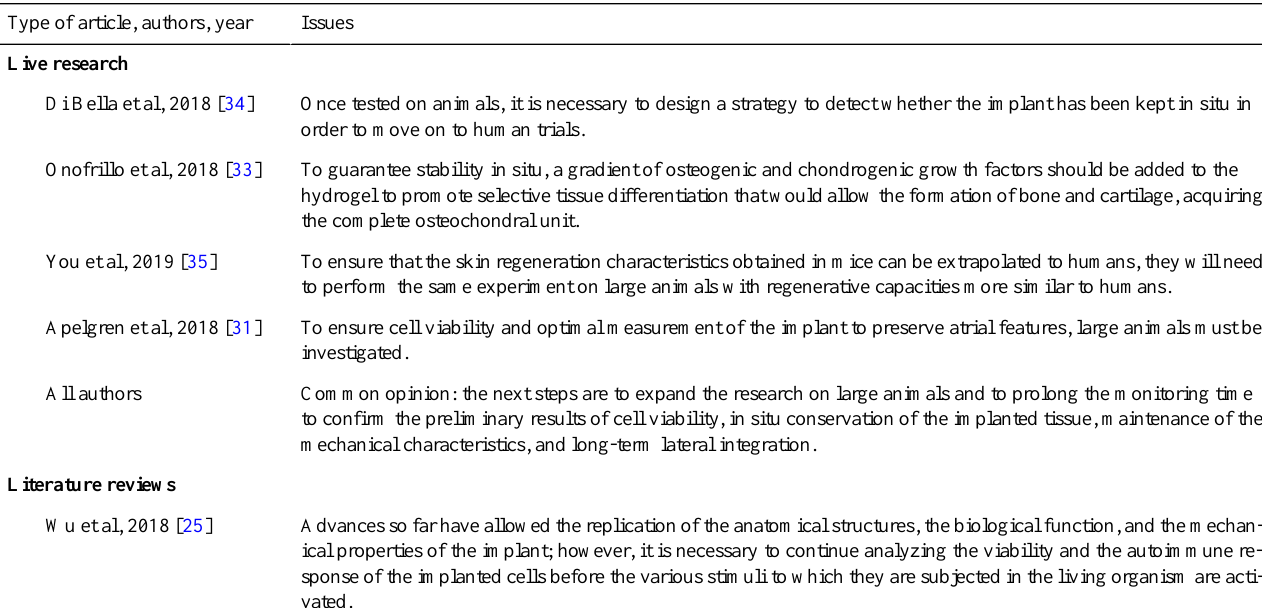
Table 5. Issues upon which the authors